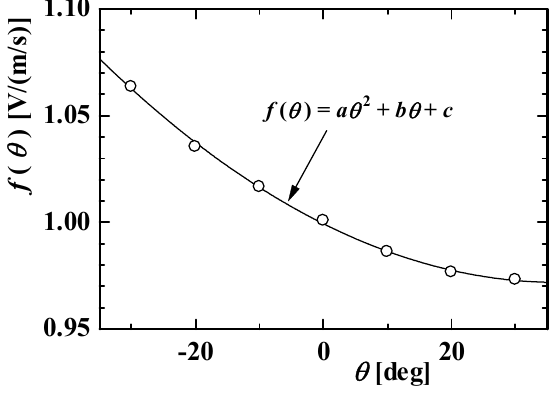
Fig. 11 Calibration curve of f ( θ ) versus